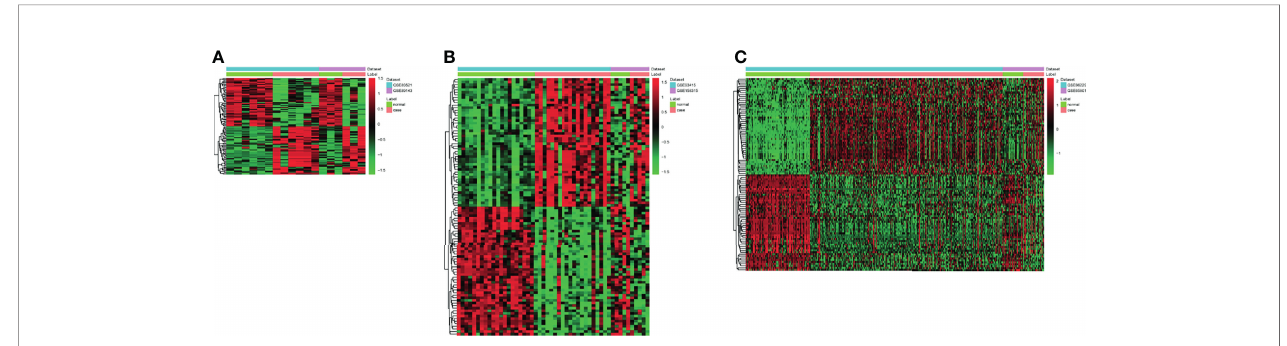
FIGURE 1 | The heat map of the top 100 differentially expressed circRNAs (A) , miRNAs (B) , and mRNAs (C) in gastric cancer (GC).